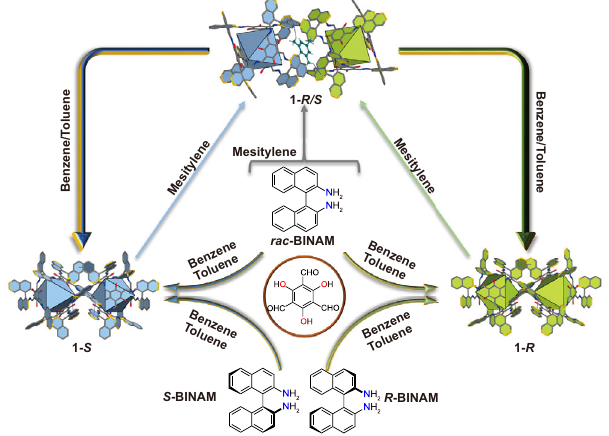
Fig. 4 Schematic illustration of structural formation. The synthesis of 1 and the reversible supramolecular structural transformation between homochiral and racemic structures under different 3.5 days, the crystals of 1- R / S ⊃ mesitylene were obtained as con fi rmed by SCXRD and PXRD (Supplementary Fig. 20). The obtained racemic co-crystals can return to homochiral crys- tallization in toluene (Supplementary Fig. 20). While it has been reported the transformation of the crystals of homochiral structure to the racemate 16 – 19 , controllable reversible trans- formation between a single crystal of homochiral and racemic structure is rare.